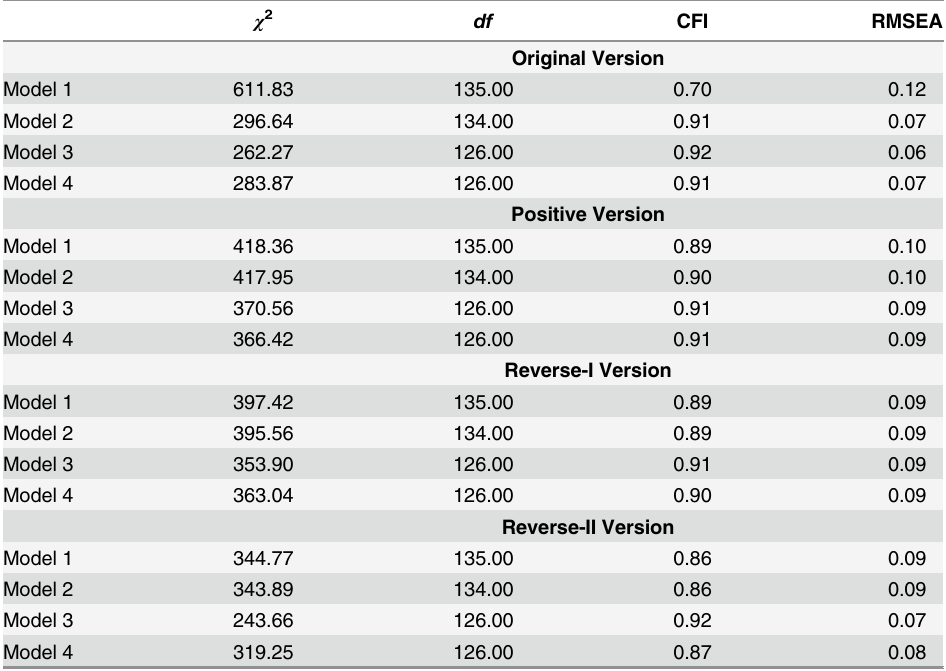
Table 8. CFA results for the four models fit to the four scale versions. χ 2 df CFI